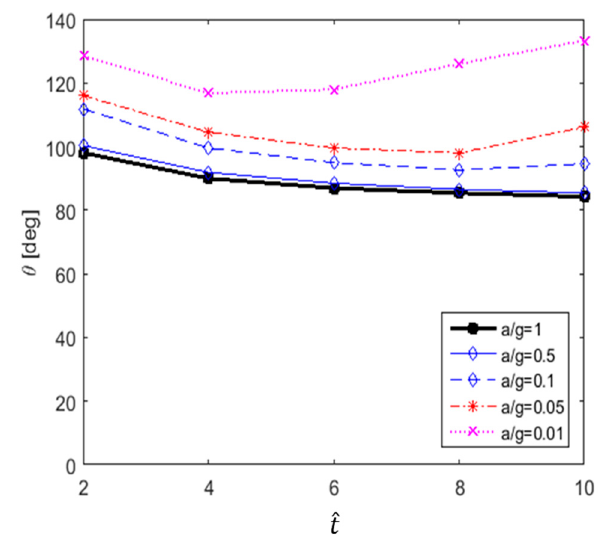
Figure 20. Separation angle versus 𝑡̂ for various accelerations